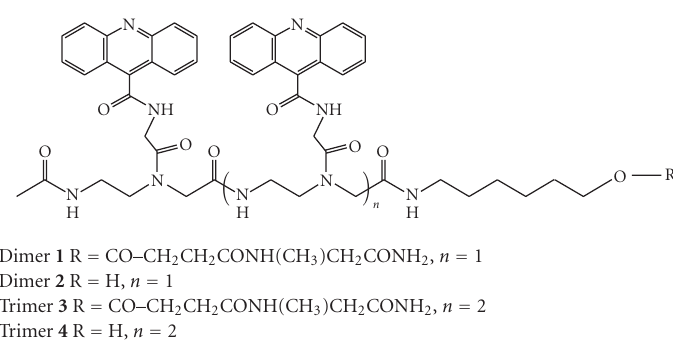
Figure 1: Structure of the acridine derivatives